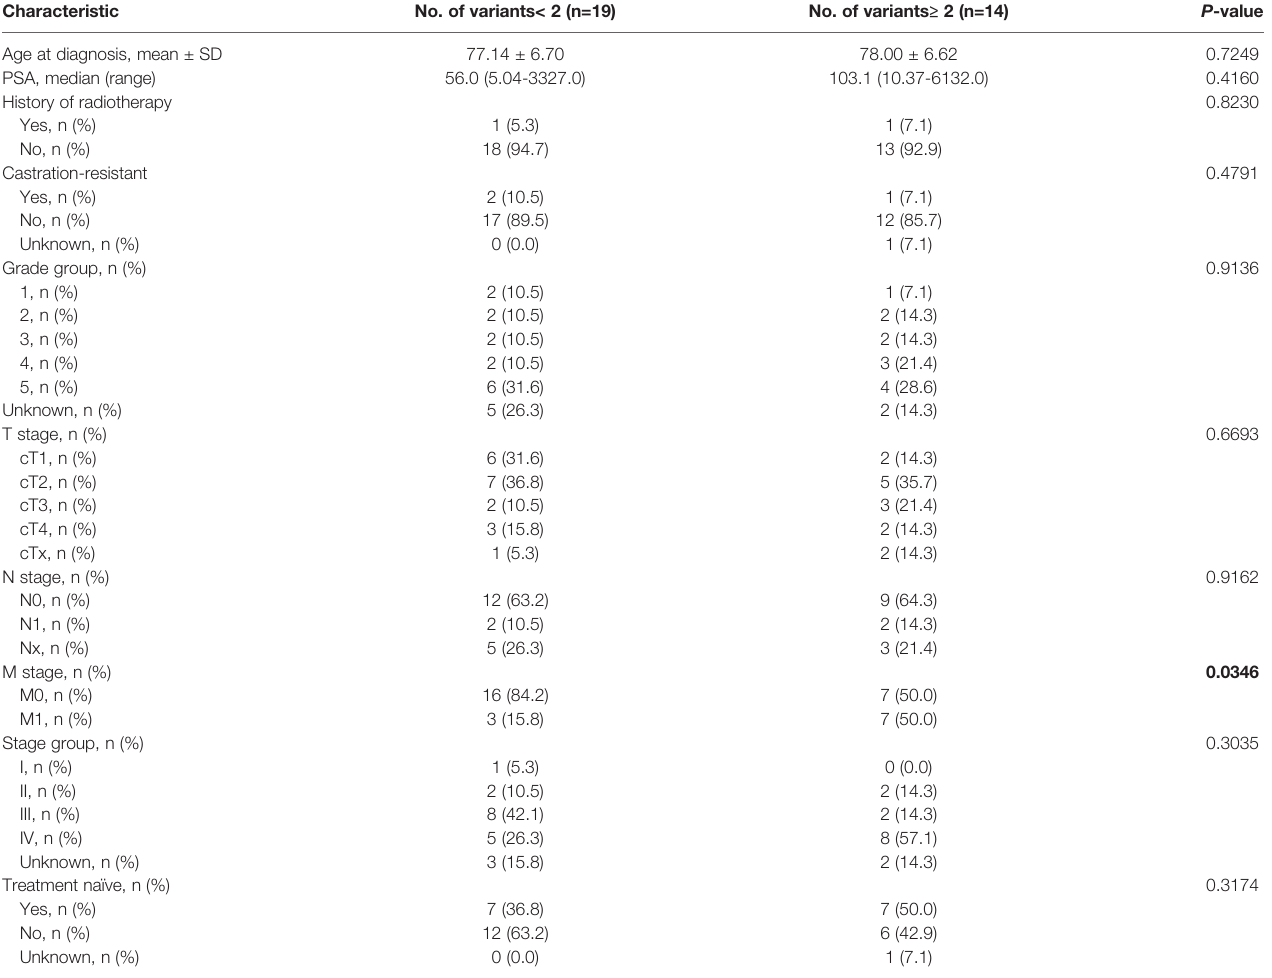
TABLE 1 | Correlation between No. of mutations and clinicopathological characteristics of the PCa patients.